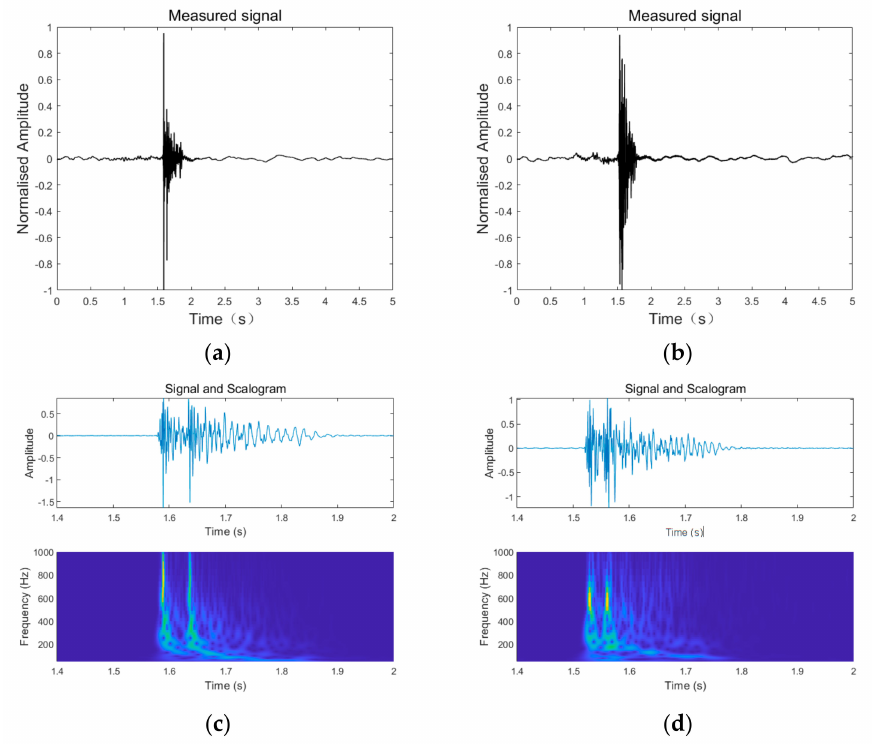
Figure 14. Received signals derived from explosive-sound sources, which detonated at ( a ) 25 m and ( b ) 50 m, ( c , d ) filtered signals in the time domain and their wavelet